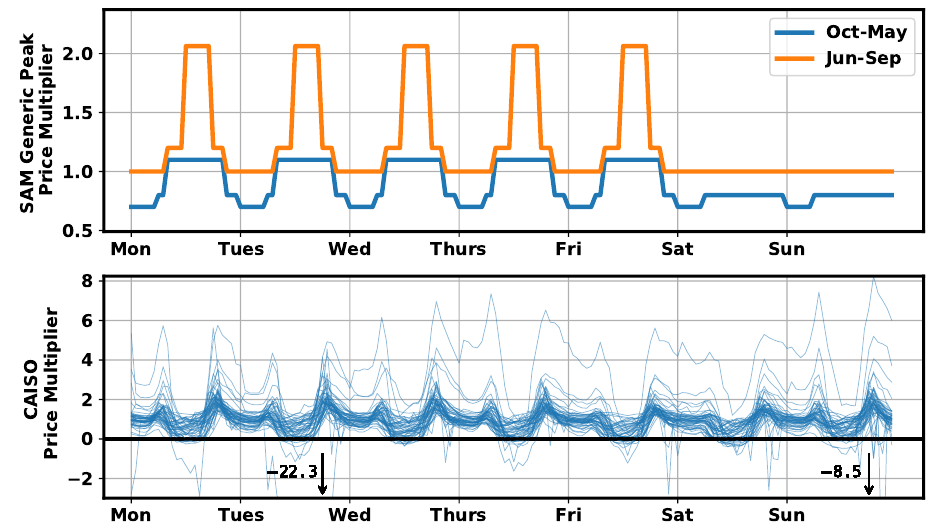
Figure 2. Price multipliers used to simulate different market conditions: ( top ) generic peak pricing schedule from SAM and ( bottom ) normalized locational marginal price from CAISO. Some negative pricing outliers for CAISO are not directly shown in the axis but are annotated in the